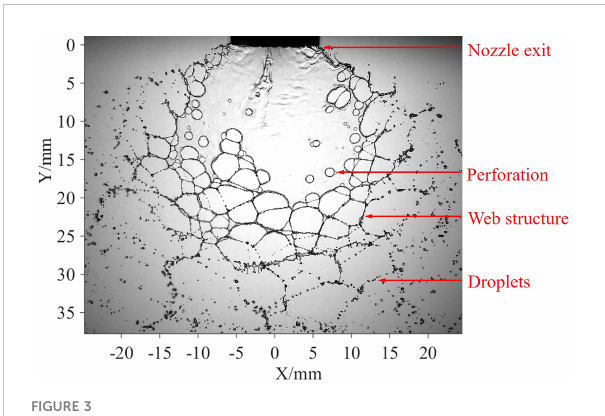
FIGURE 3 Sheet structure of oil-based emulsion spray.